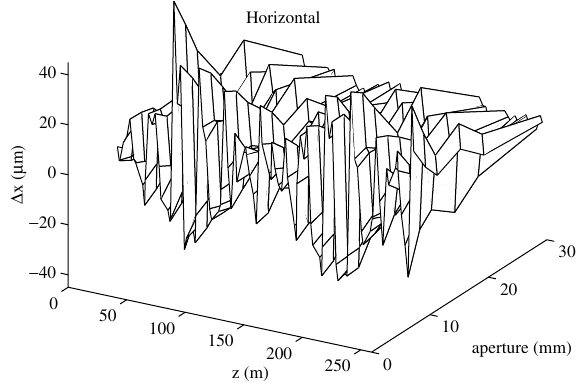
FIG. 8. Horizontal orbit deviation versus scraper aperture.